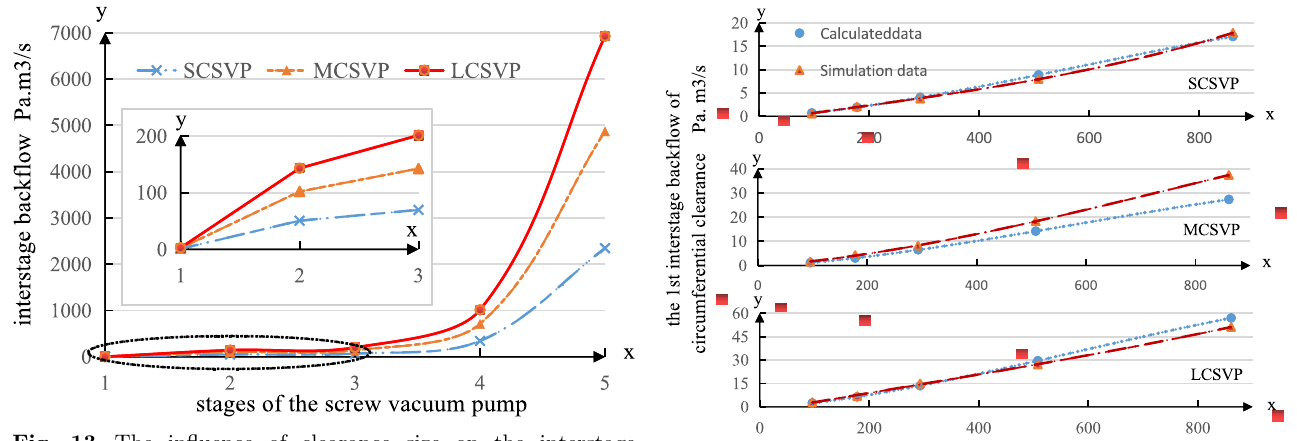
Fig. 13. The in fl uence of clearance size on the interstage back fl ow.